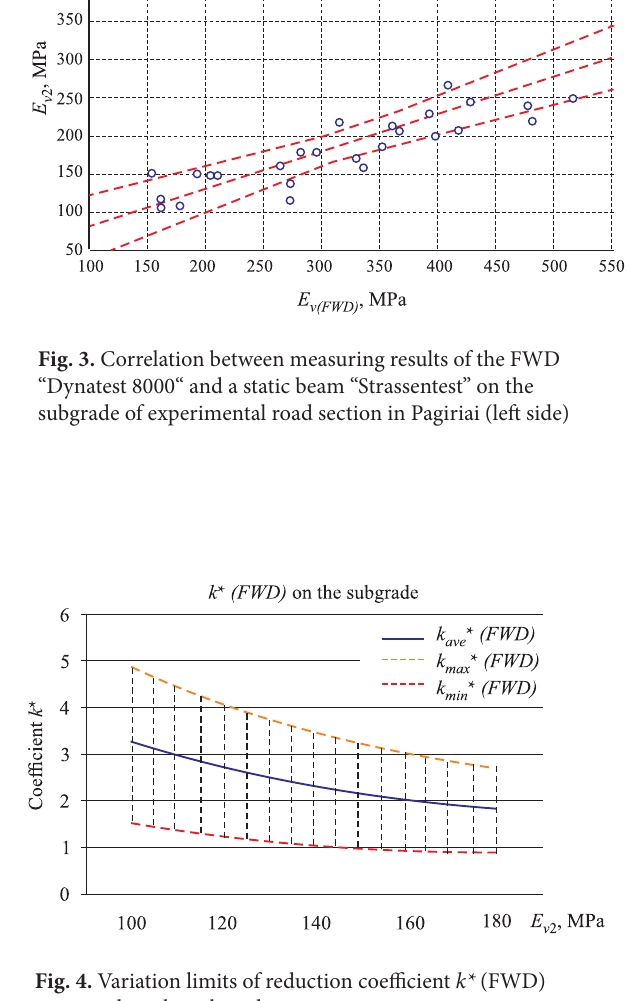
Fig. 4. Variation limits of reduction coefficient k* (FWD) measured on the